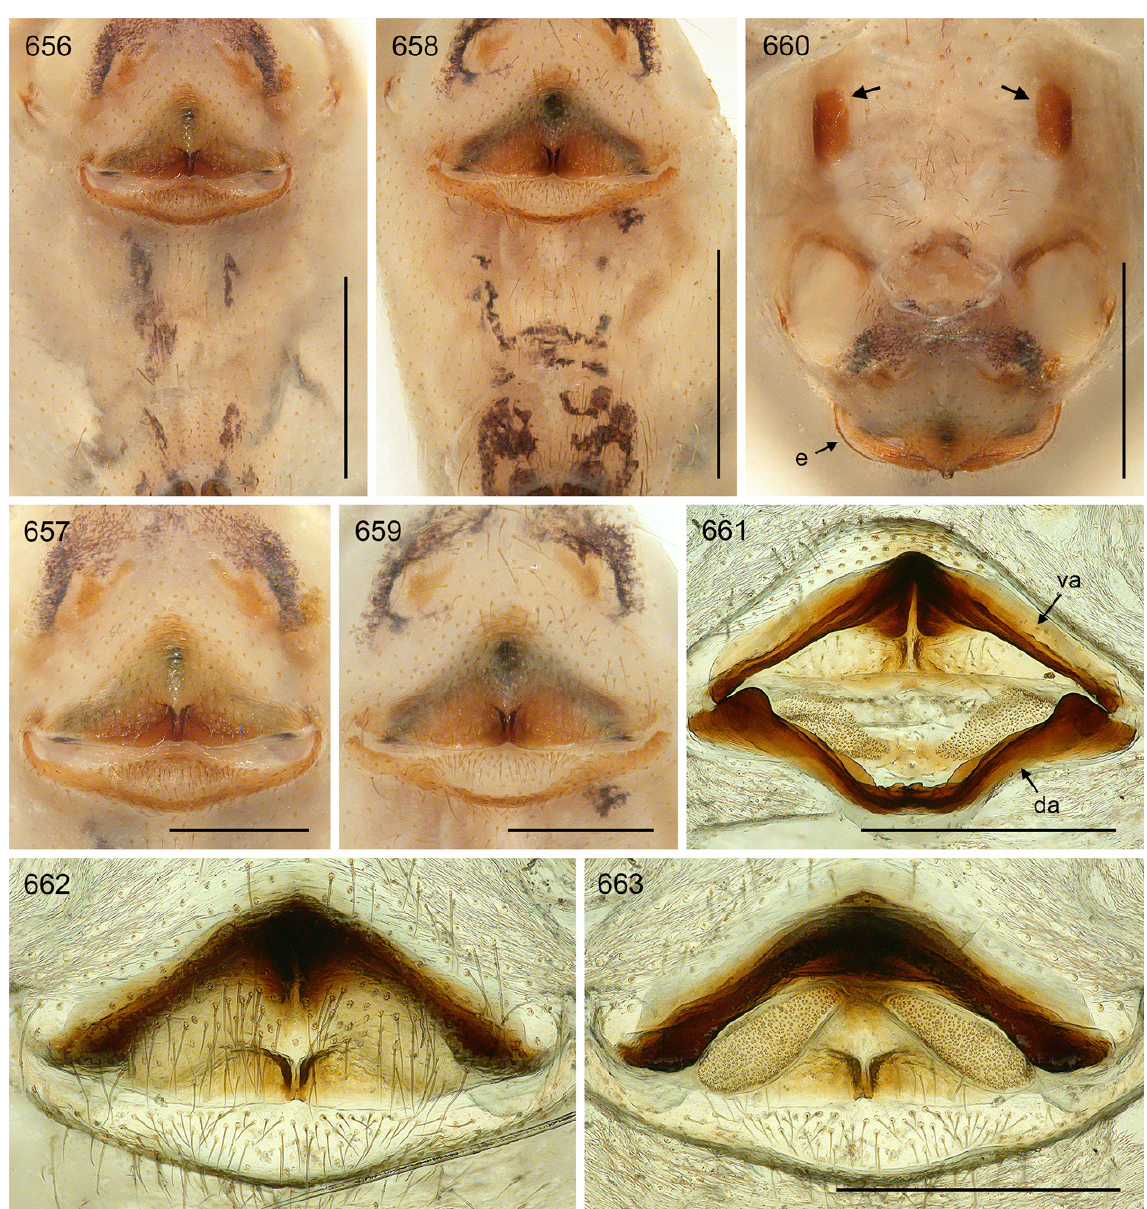
Figs 656–663. Crossopriza sanaa sp. nov.; females from Yemen, Sana’a (656–657, 660: NMNL ARA 15214; 658–659, 661–663: NMNL ARA 15215). 656–659 . Abdomens and epigyna, ventral views. 660 . Abdomen, frontal view; arrows: stridulatory plates. 661–663 . Female internal genitalia, dorsal view (with dorsal arc tilted backwards), ventral view, and regular dorsal view. Abbreviations: da = dorsal arc; e = epigynum; va = ventral arc. Scale bars: 656, 658, 660 = 1.0 mm; 657, 659, 661–663 = 0.5